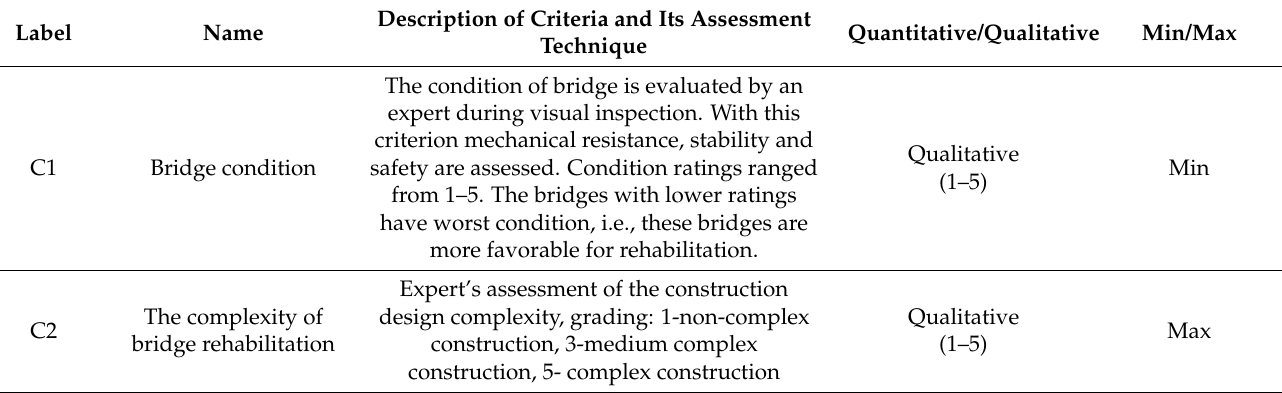
Table 1. Criteria label and